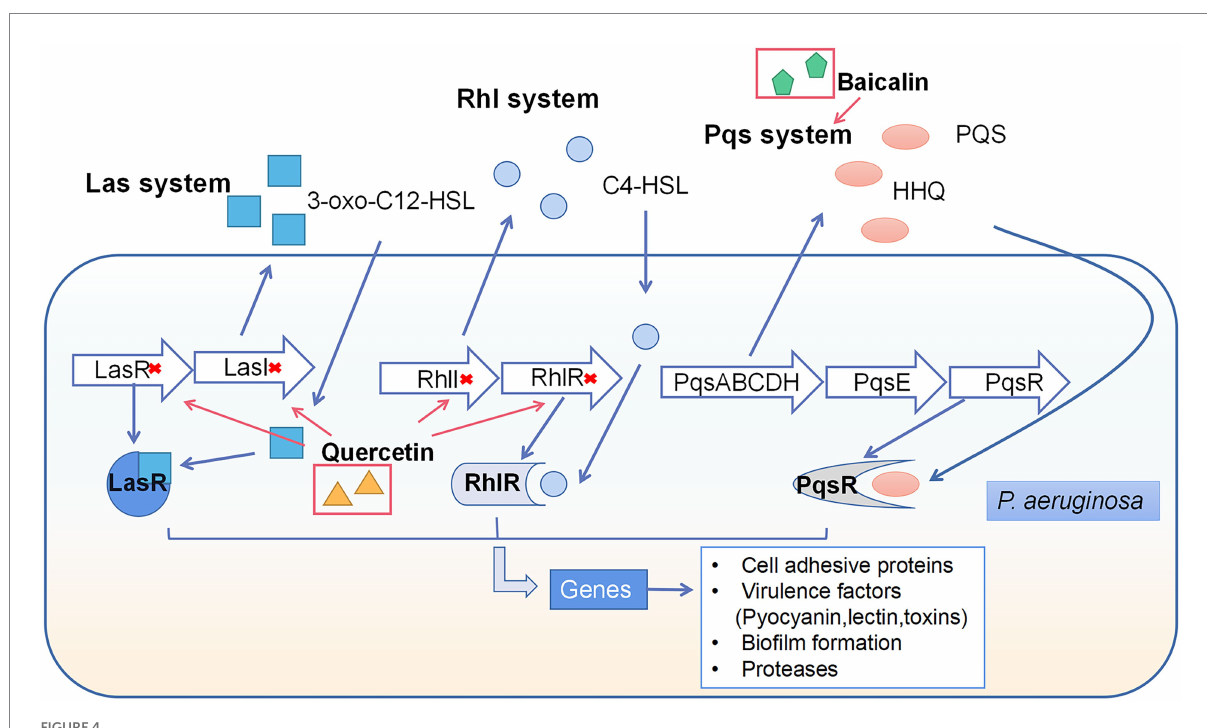
FIGURE 4 Quorum sensing system in P. aeruginosa and the interference of natural products on quorum sensing system. There are three key pathways in the P. aeruginosa QS system: two LuxI/LuxR-type QS pathways and the pseudomonas quinolone signal (PQS) system, named Las, rhl, and pqs. The synthesis of AI’s 3-oxo-C12-HSL and C4-HSL is modulated by Las and Rhl, which serve as their autoinducers, respectively. In addition, alkyl-4- quinolones (AQs), including PQS and HHQ, are signal molecules in the PQS pathway. Interconnections between the three pathways regulate the activity of the QS system, resulting in changes in cell adhesive proteins, virulence factors, biofilm formation and proteases. Quercetin inhibited LasI, LasR, RhlI, RhlR gene expression and baicalin inhibited Pqs